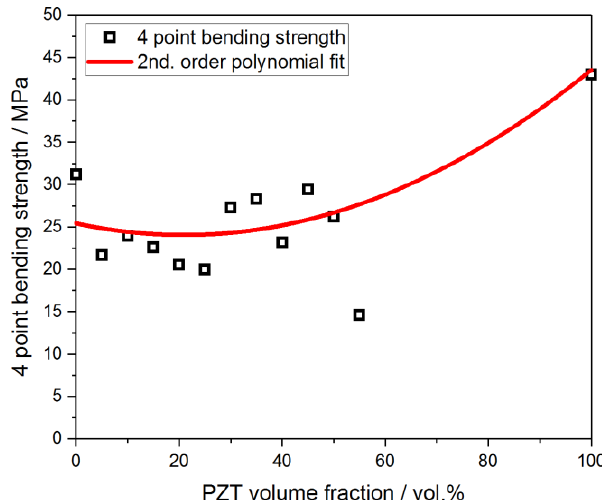
Figure 6. Four-point bending strength of PZT-polymer composites cured at 200 °C as a function of the filler content.